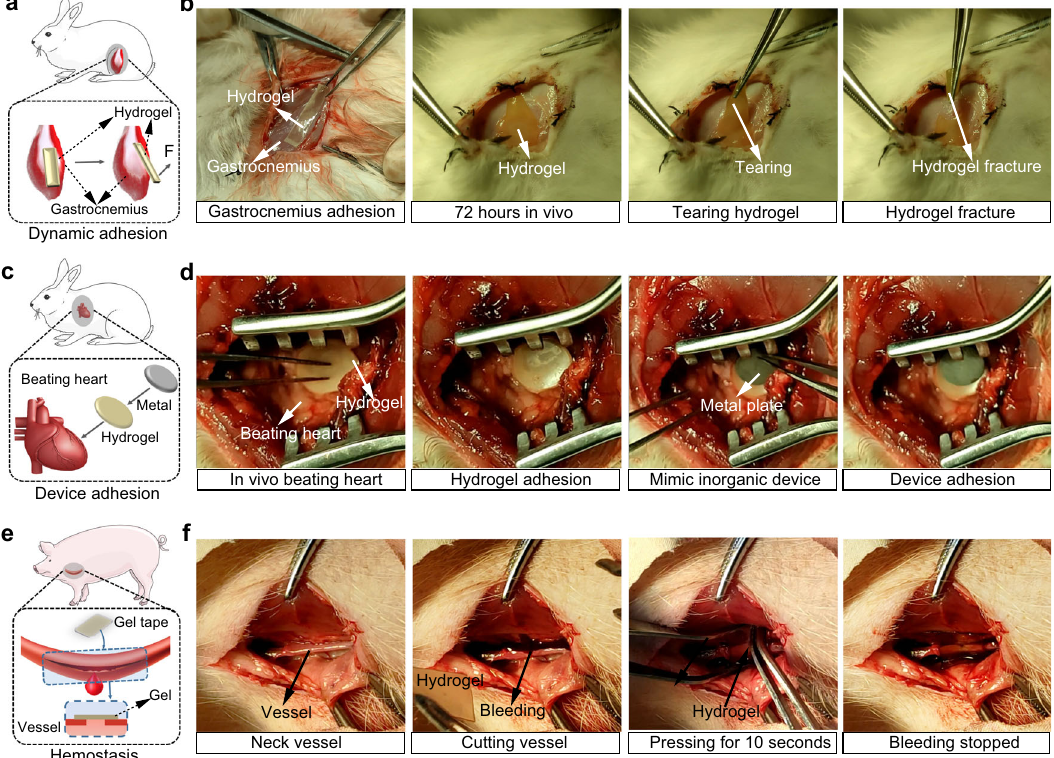
Fig. 5 In vivo adhesion and hemostasis of Electro-Ox hydrogel tape. a Schematic illustration of adhesion on rabbit gastrocnemius. b Adhesion of Electro- Ox hydrogel tape on rabbit gastrocnemius before and after 72 h in vivo. c Schematic illustration of device adhesion on a beating rabbit heart. d Adhesion of a metal sheet on a beating rabbit heart via Electro-Ox hydrogel tape in vivo. e Schematic illustration of hemostasis on the bleeding carotid artery of a pig. f Hemostasis of the bleeding carotid artery of a pig using Electro-Ox hydrogel tape in